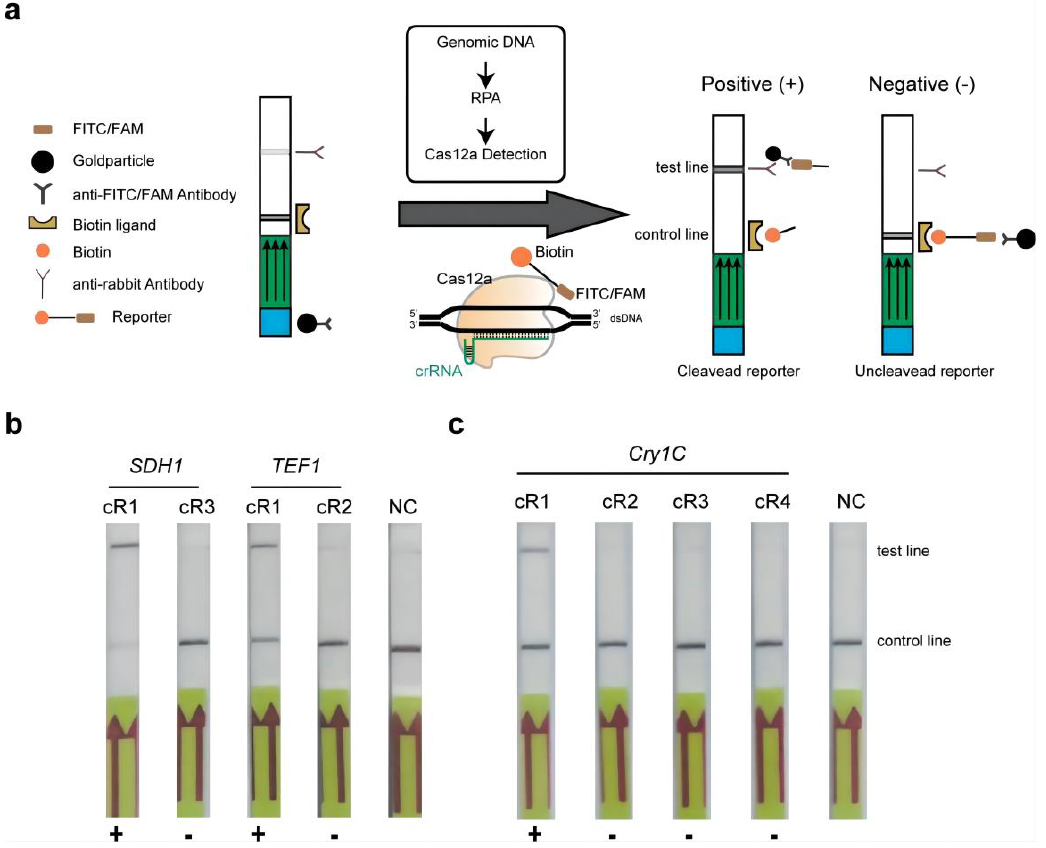
Figure 5. A paper-based RPA-Cas12 nucleic acid detection system that can be completed at body temperature [31]. Schematic diagram of detection principle ( a ); Positive results for different target genes ( b , c ).